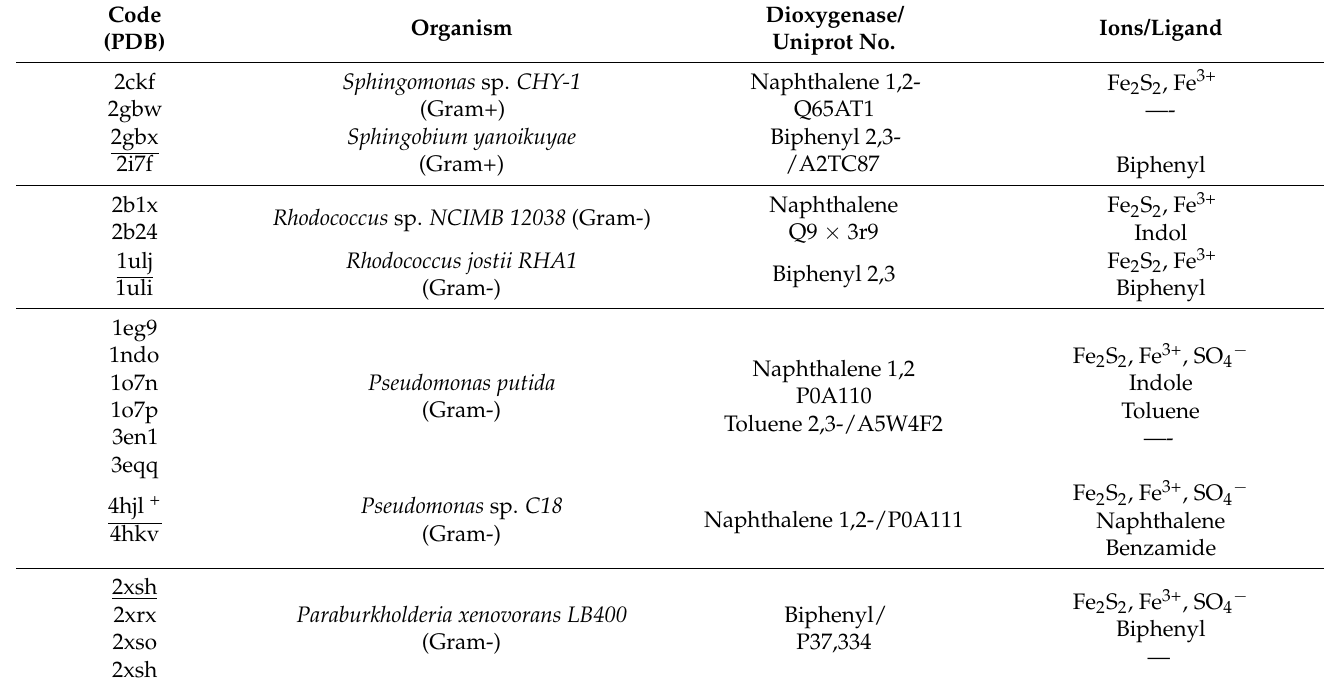
Table 1. Protein Data Bank ID codes of dioxygenases from different